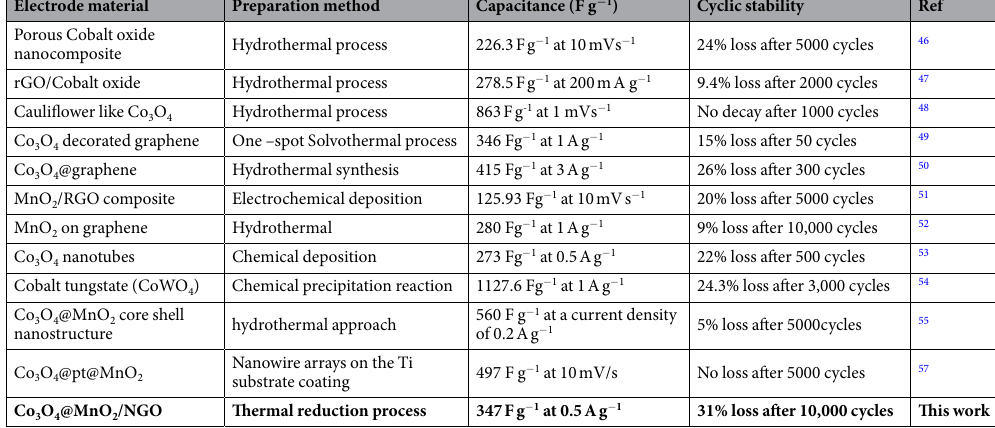
Table 1. Comparison of the supercapacitor values of various nanostructured of cobalt oxides (Co 3 O 4 ), Manganese oxides (MnO 2 ) and Co 3 O 4 @MnO 2 /NGO electrodes reported in the